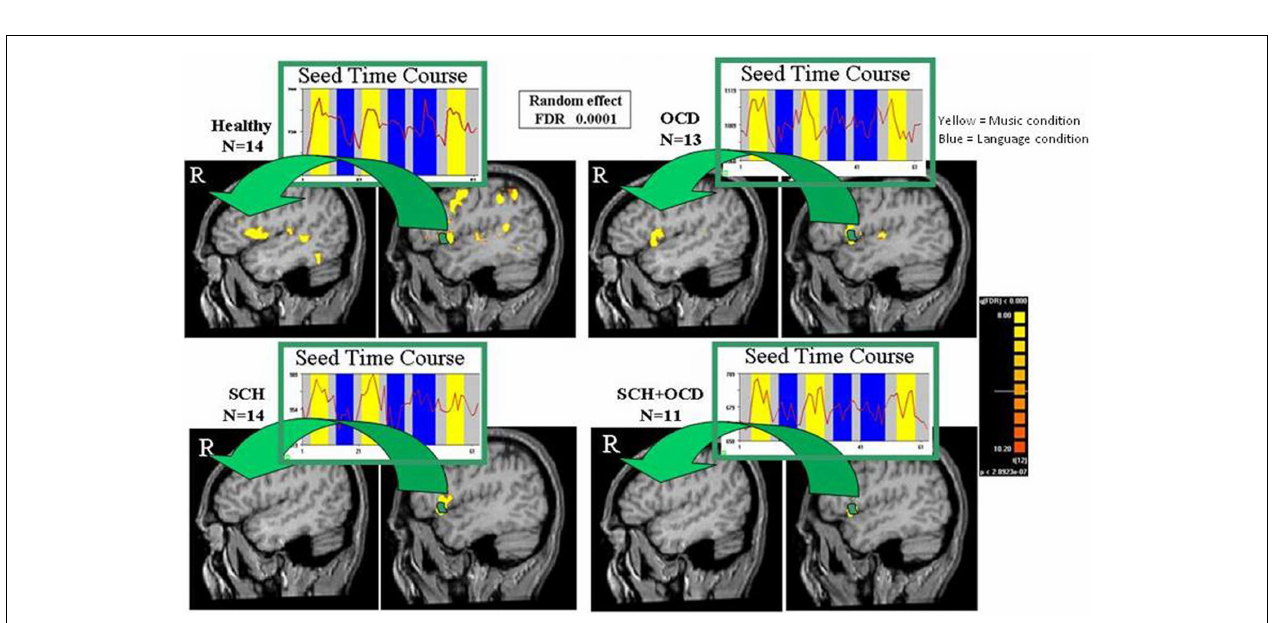
shown in sagittal views for all groups.The arrows point to the homolog IFG, where correlated activation with the left IFG was found for healthy controls and OCD, but not in SCH patients with and without